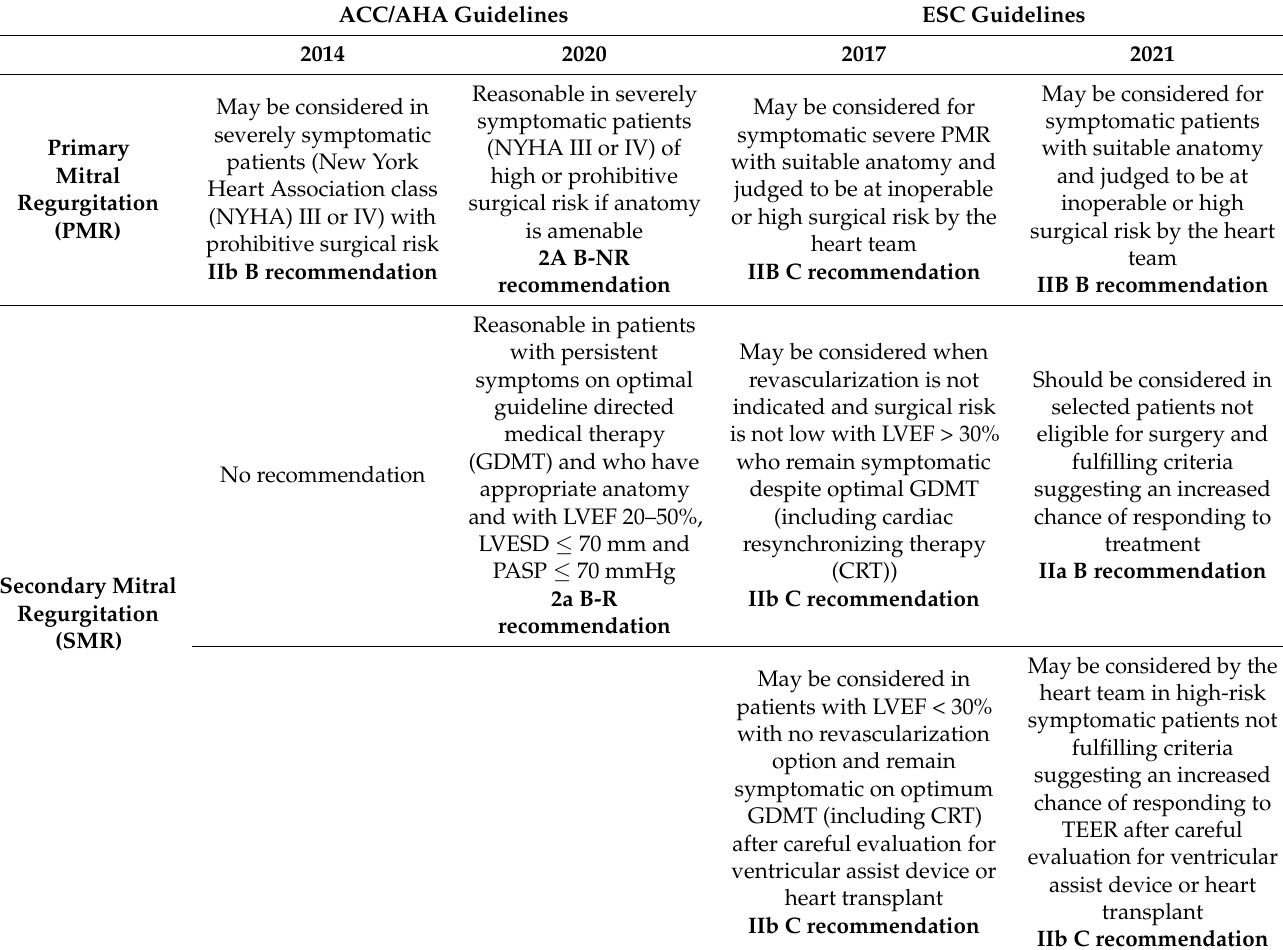
Table 2. Table comparing current and previous guideline recommendation for transcatheter MV